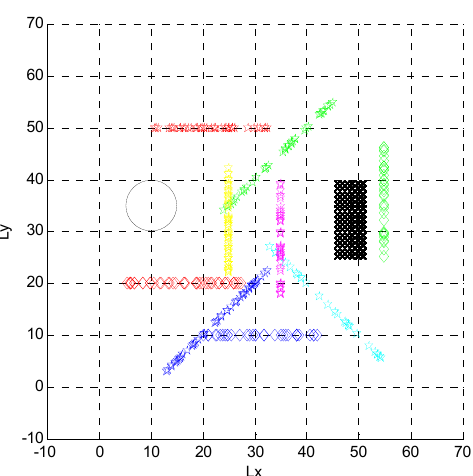
Figure 4. Unmanned aerial vehicle (UAV) search result under proposed method.